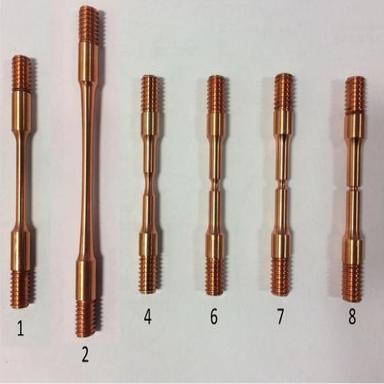
Geometry of copper specimens tested (for stainless steel, specimens 3 and 5, as defined in Table 1, have been used instead of specimen 4).